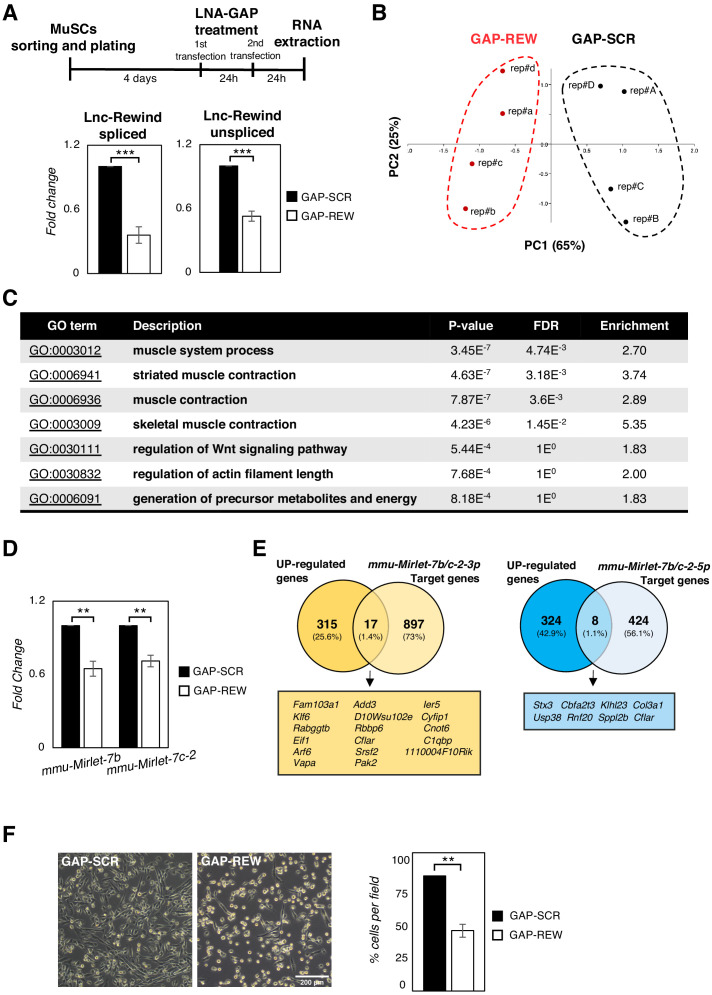
Lnc-Rewind regulates muscle system processes and MuSC expansion.(A) Upper part: Experimental timeline used for the transfection of MuSC-derived myoblasts with GAP-SCR or GAP-REW. Lower part: qRT-PCR quantification of Lnc-Rewind spliced and unspliced transcript in MuSC-derived myoblasts treated with GAP-SCR or GAP-REW. Data were normalized to Gapdh mRNA and expressed as fold change of the mean ± SEM of four biological replicates. (B) PCA analysis of DEGs upon Lnc-Rewind depletion. GAP-REW and GAP-SCR RNA-seq replicates are shown, respectively, as red and black dots. PC1 and PC2 represent the top two dimensions of the PCA which account, respectively, for 65% and 25% of the total variability. (C) Table shows the GO terms, their description, the p-value, the false discovery rate (in decreasing order of statistical significance), and the enrichment of the different categories listed in the diagram of Figure 2B. (D) qRT-PCR quantification of mmu-Mirlet7-b and mmu-Mirlet7-c-2 miRNAs in GAP-SCR- or GAP-REW-treated MuSC-derived myoblasts. Data were normalized to Gapdh mRNA and expressed as fold change of the mean ± SEM of three biological replicates. (E) Target prediction analyses performed by crossing the genes upregulated upon Lnc-Rewind depletion with the mmu-Mirlet7b/c2-3p (yellow) and mmu-Mirlet7b/c2-5p (blue) predicted target genes. Predictions were obtained from Targetscan database (Agarwal et al., 2015). (F) Representative images (left) and cells number quantification (right) of MuSC-derived myoblasts treated with GAP-SCR or GAP-REW. Data represent the mean percentage ± SEM of three biological replicates. Data information: *p<0.05, **p<0.01, ***p<0.001, unpaired Student’s t-test.Figure 2—figure supplement 1—source data 1.Source data for Figure 2—figure supplement 1.